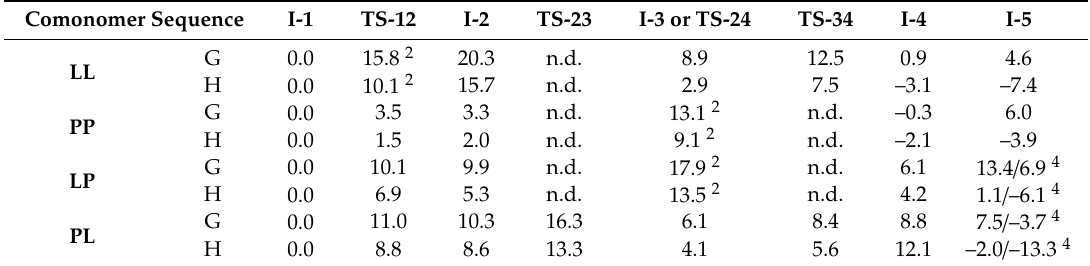
Table 2. Calculated free energies and free enthalpies (kcal / mol) of stationary points and transition states for di ff erent comonomer sequences in l -LA / MeOEP copolymerization. 1. Comonomer Sequence